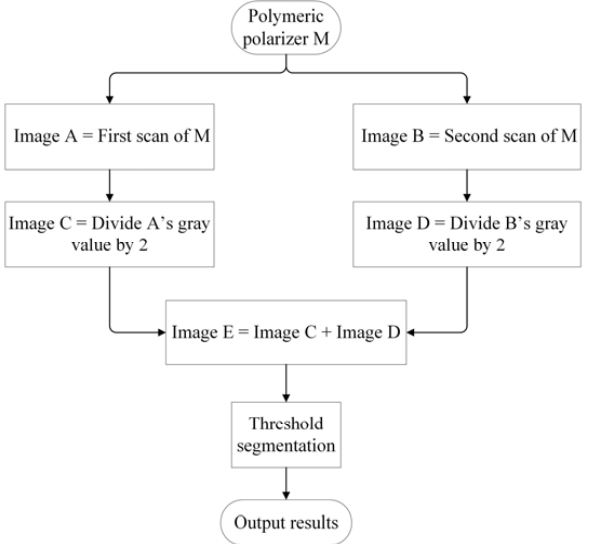
Figure 7. Two ‐ step average algorithm flowchart.